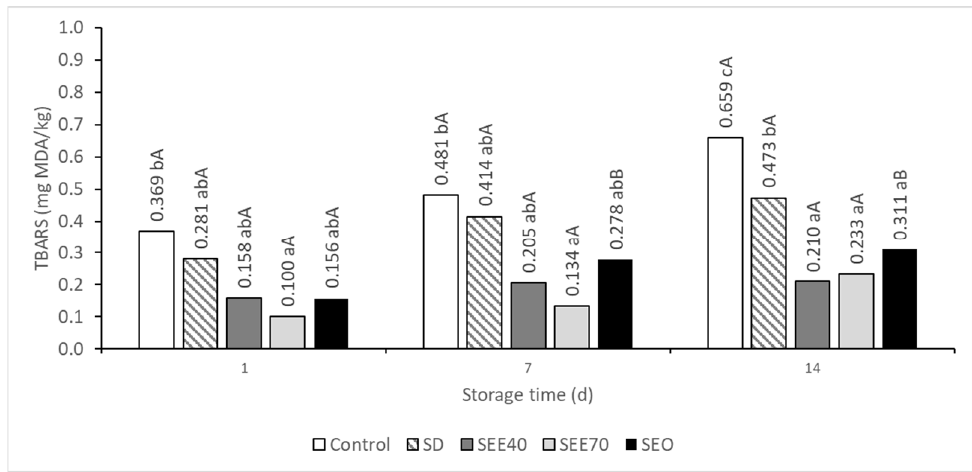
Figure 1. Changes in the TBARS value of chicken meatballs containing MSM from chickens during refrigerated storage (mean values; n = 3). Control, SD, SEE40, SEE70, and SEO: The symbols identifying the chicken meatball treatments are explained in the footnotes of Table 1. a,b Mean values marked with different letters differ significantly at p < 0.05 — the differences refer to chicken meatball treatments on a given day of storage. A,B Mean values marked with different letters differ significantly at p < 0.05 — the differences refer to days of storage of a given chicken meatball treatment.